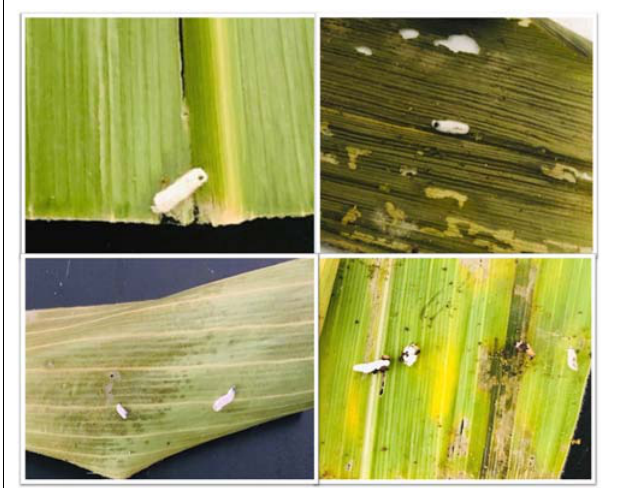
FIGURE 2 | Field collected dead larvae showing the existence of fungal outgrowth from the larval cadavers.